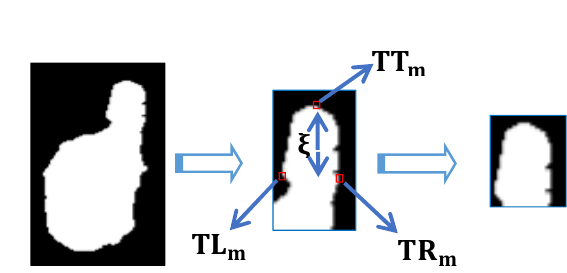
Fig. 3: Extraction of the from the ROI TT where x is the row and y the column position of a skin pixel in the image; . The extraction of ROI and TT from an input image is shown in Fig. 4. TT